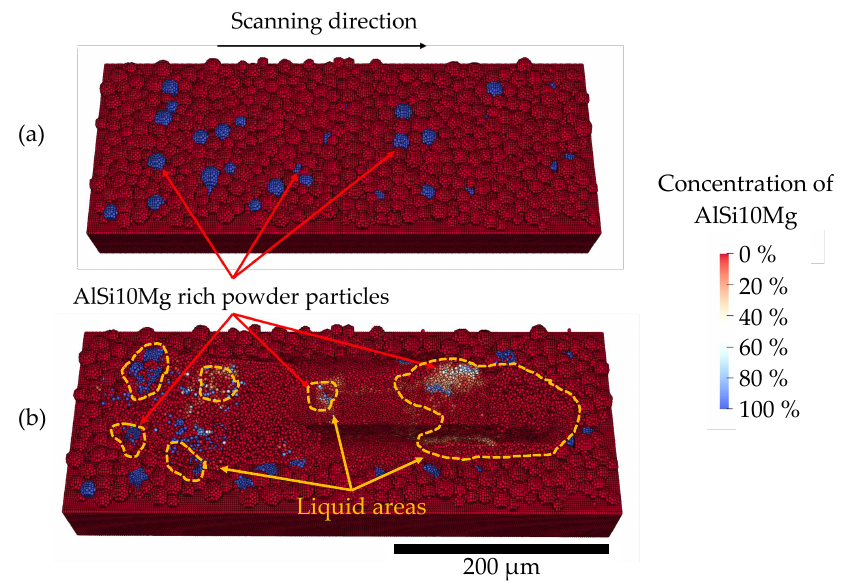
Figure 4. The initial powder bed ( a ) and the steady-state melt pool ( b ) for 316L blended with 5 wt.% AlSi10Mg.